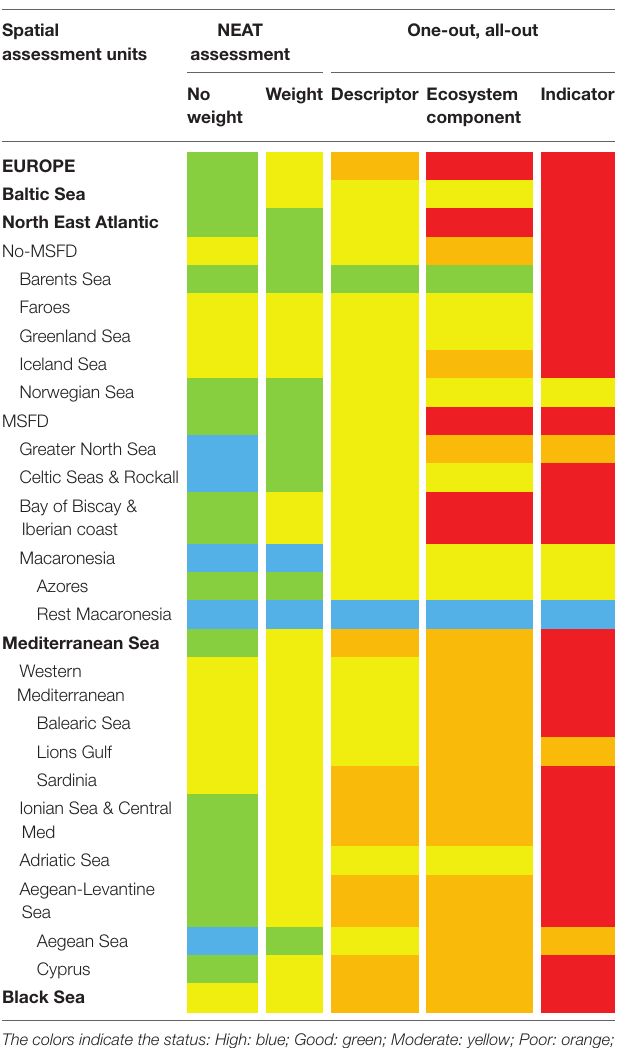
TABLE 4 | Summary of the environmental status, for the whole Europe, for the four regional seas (in bold), for the subregional seas (centered), and several subunits (aligned to the right), assessed following different methods: (i) NEAT calculated weighting and non-weighting by Spatial Assessment Unit (SAU); and (ii) using the “One-out, all-out” principle at different levels: the worst of the values of the three descriptors, the worst of the ecosystem components and the worst of the indicators studied, at the subunits or subregion level and then integrating the worst of them at regional and European levels.